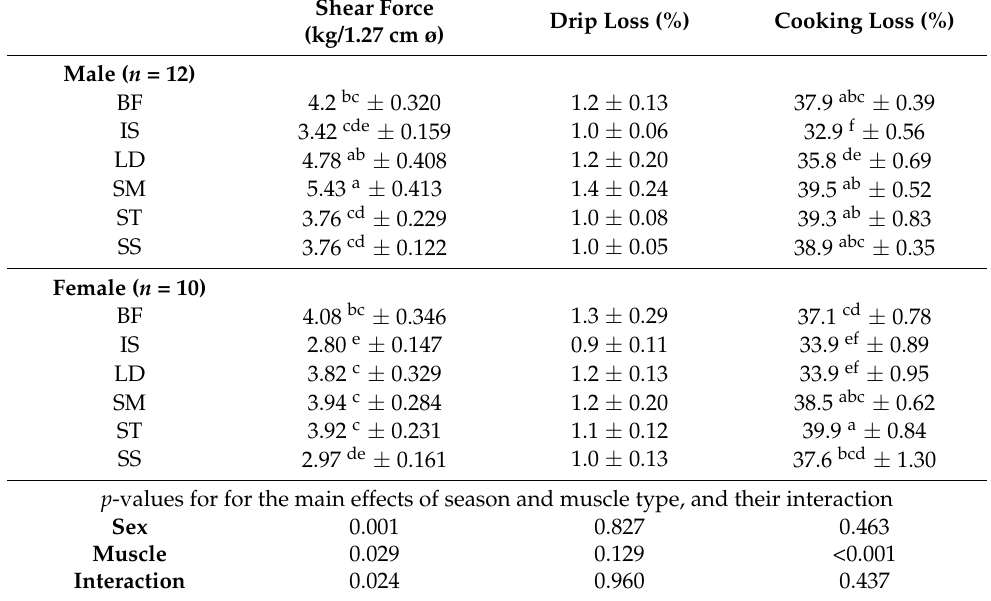
Table 3. Mean values ( ± standard errors) and least significant differences (LSD) for shear force, drip loss and cooking loss for the longissimus dorsi (LD), biceps femoris (BF), semimembranosus (SM), semitendinosus (ST), supraspinatus (SS) and infraspinatus (IS) muscles from male and female red hartebeest from